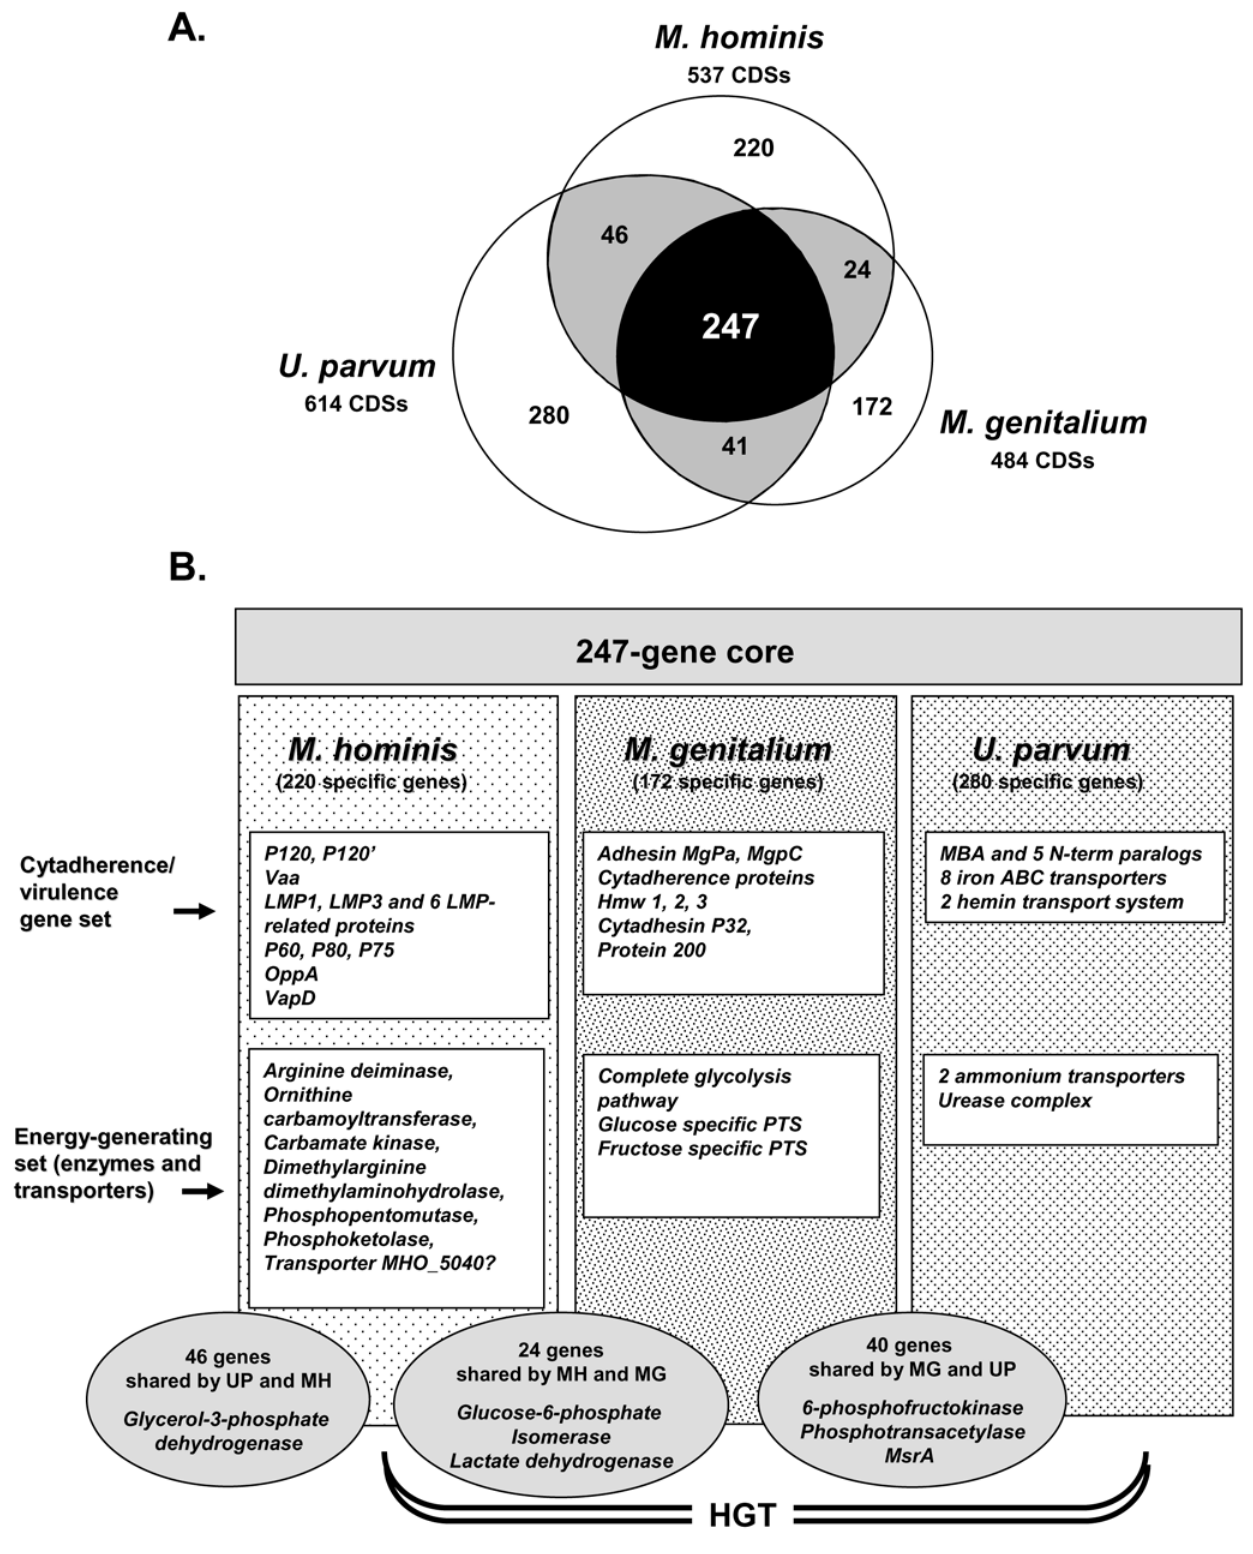
Figure 1. Comparative analysis of the genomes of three minimal mollicutes affecting humans. (A) Number of specific and shared CDSs for the genomes of M. hominis PG21, M. genitalium G37, and U. parvum serovar 3. (B) Focus on known species-specific proteins involved in cytadherence/virulence and energy-generating pathways. LMP, large membrane protein; PTS, phosphoenolpyruvate phosphotransferase system; HGT, horizontal gene transfer; UP, U. parvum ; MH, M. hominis ; MG, M. genitalium .